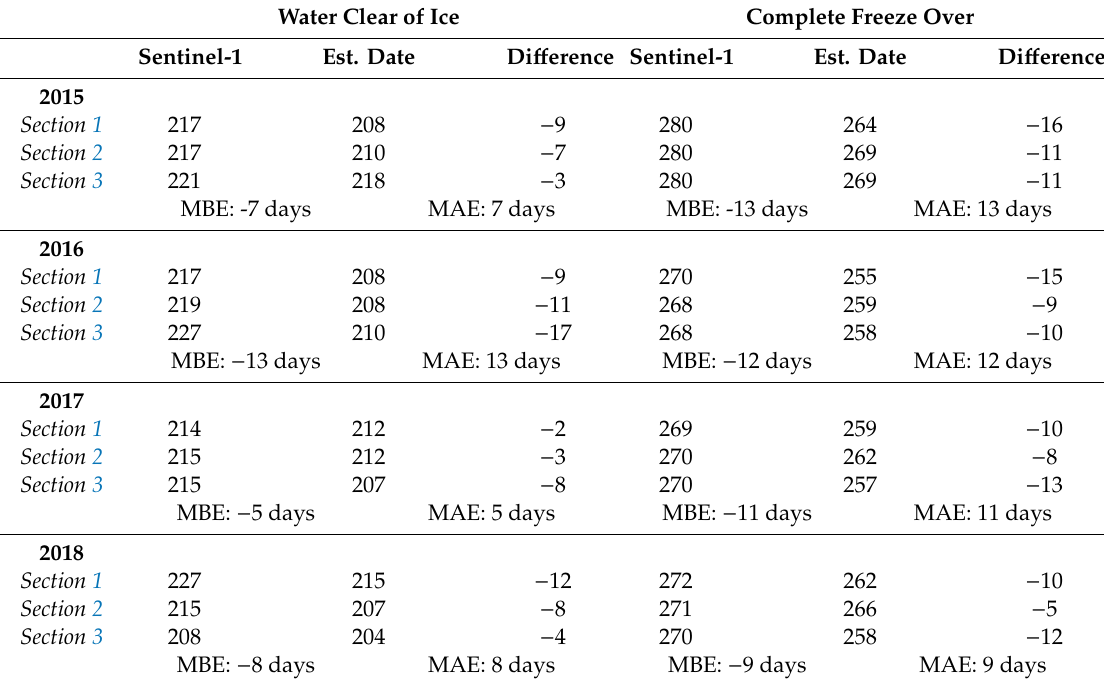
Table 5. Mean bias and mean absolute errors for the determination of the overall lake ice phenology event dates (WCI and CFO) using the Otsu segmentation